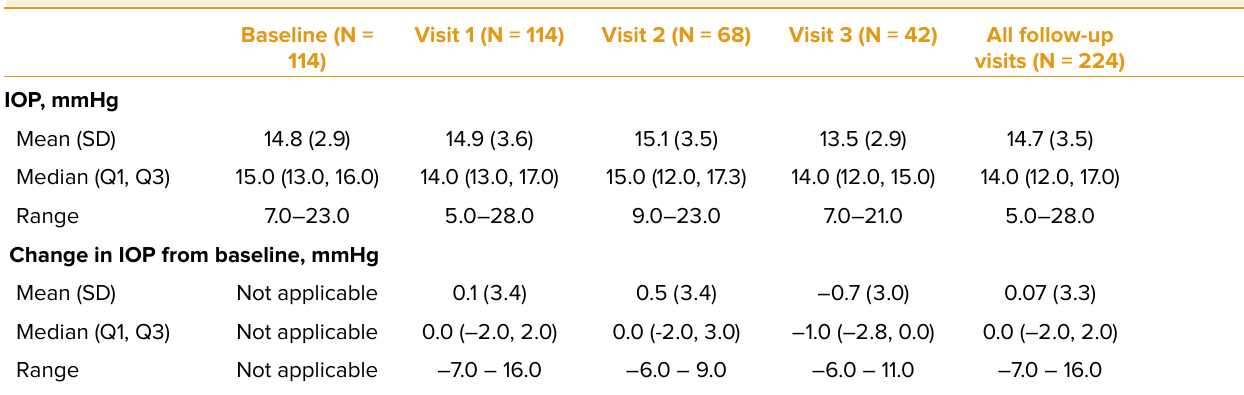
Table 2. Description of IOP at each